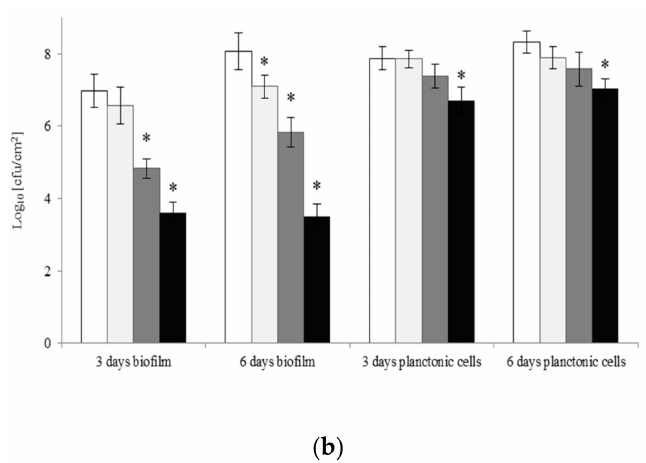
Figure 2. Effect of gemini C6 ( a ) and monomeric DTAB ( b ) surfactants on biofilm formation by A. lannensis FMW1. The results are presented after 1-h cells treatment by surfactants in the concentrations: 1 / 4 MIC (clear grey bar), 1 / 2 MIC (dark grey bar), MIC (black bar), and compared to the control sample without surfactants (white bar). * Reduced value of log 10 differed significantly from the control without